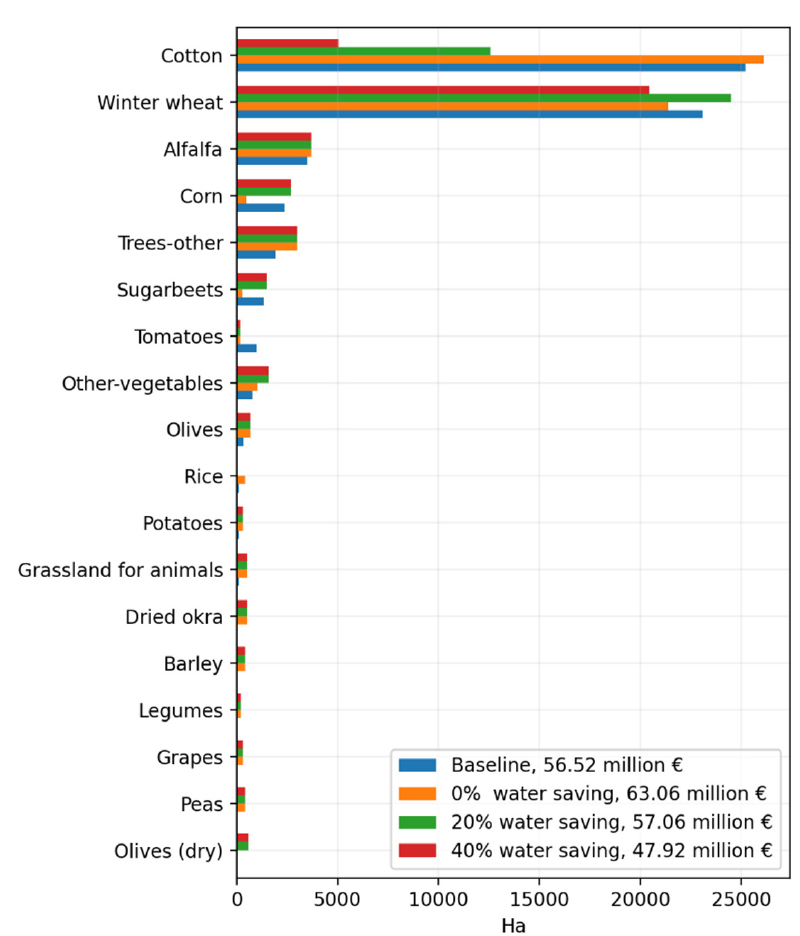
Figure 2. Crop areas for the baseline and the optimal solutions for water use reduction of 0, 20, 40%. The label shows the total annual profit for the crop selection.